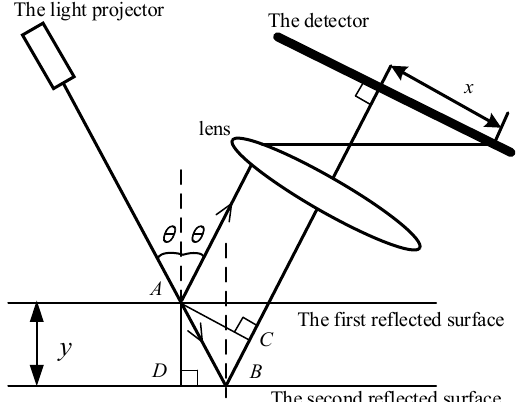
Figure 1. The measuring principle of triangulation.